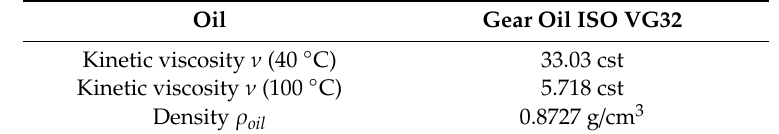
Figure 12. Oil fraction of the probe at the gear meshing zone.